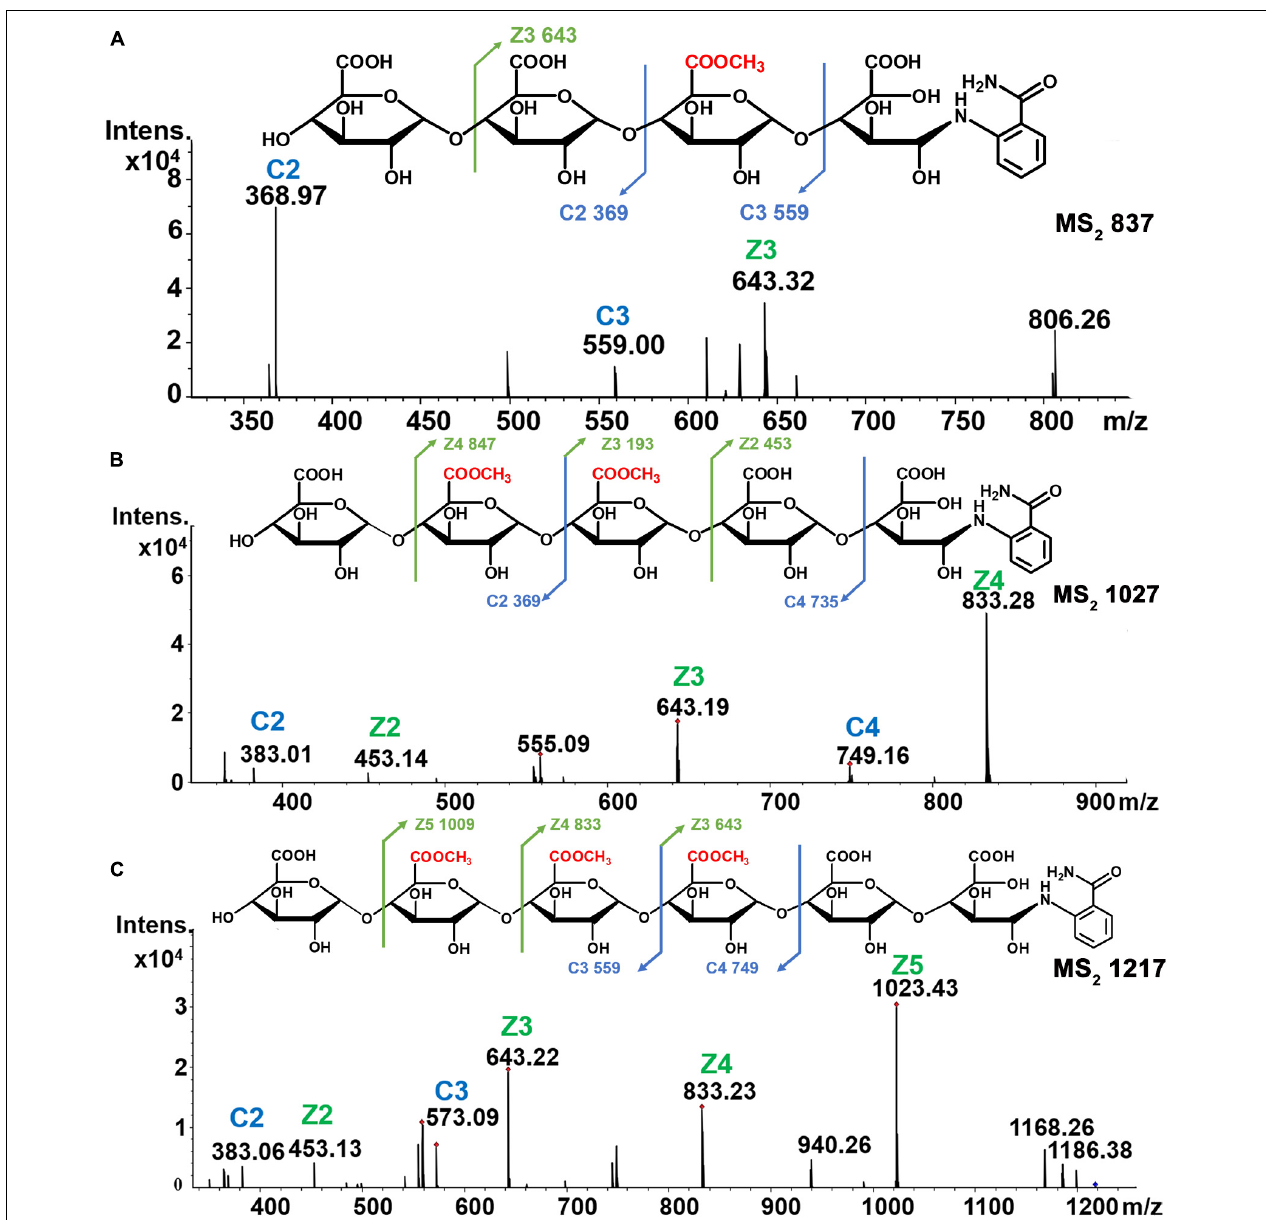
FIGURE 6 | Chemical structures and MS 2 spectra of oligogalacturonides of different methyl groups. (A) Mono-esterified of DP4. (B) Di-esterified of DP5. (C) Tri-esterified of DP6.